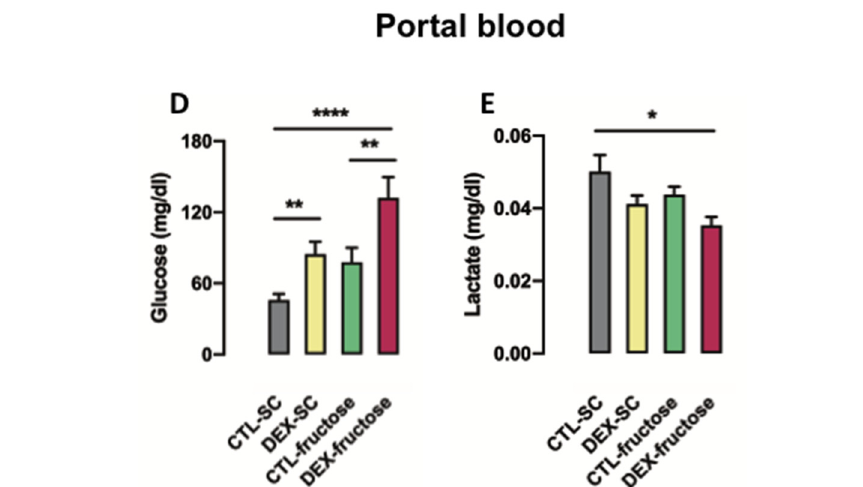
Figure 2. E ff ects of fructose on biochemical parameters of systemic and portal blood in rats exposed to dexamethasone (DEX) in utero. Systemic blood samples were collected to measure glucose ( A ), triacylglycerol ( B ), and total cholesterol ( C ). Portal hepatic vein samples were collected to measure glucose ( D ) and lactate ( E ). Results are presented as mean ± standard error of the mean (S.E.M.).